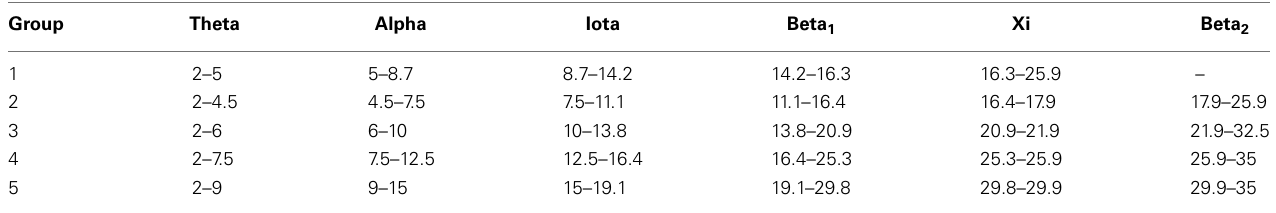
confidence intervals for the linear trends, and the corresponding 99% confidence bounds for the slopes and intercepts are indicated. Note that beta 2 frequencies can exceed 35Hz (the maximum frequency of fitted Gaussian peaks), since model spectra were evaluated up to